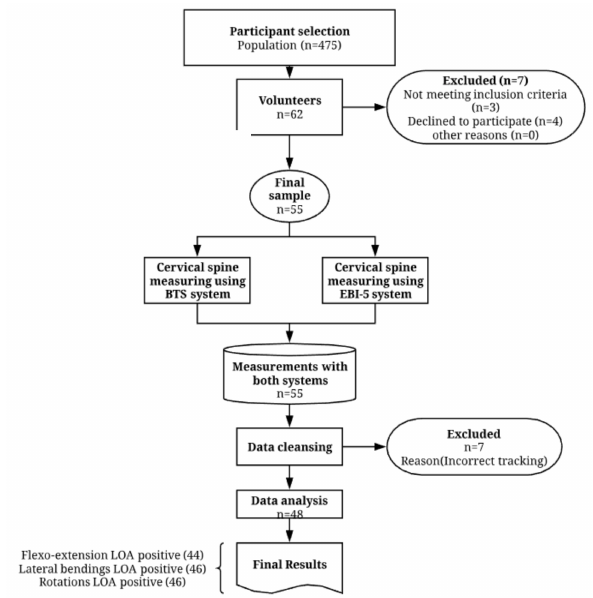
Figure 3. STARD (standards for reporting diagnosis accuracy studies) flowchart of the validation